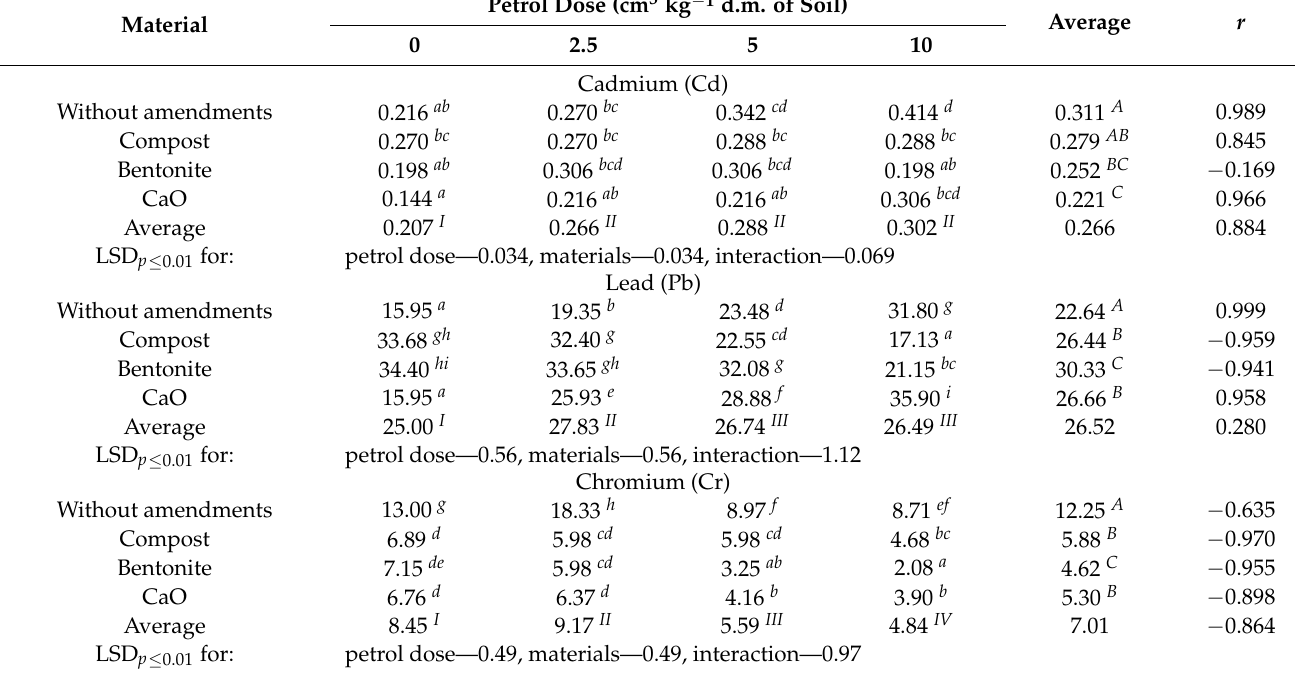
Table 1. The content of cadmium, lead, and chromium in the soil (mg kg − 1 d.m.).